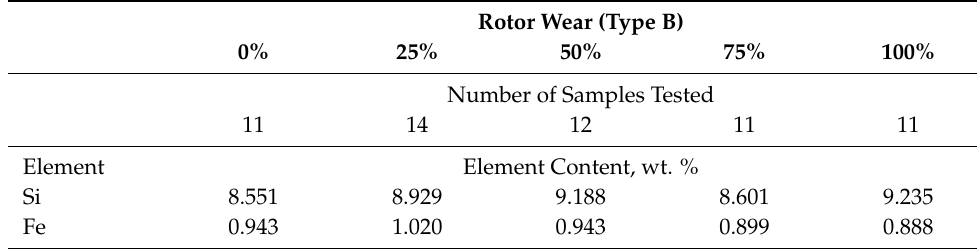
Table 8. Average chemical composition of samples taken from melts during operational experiments—type B